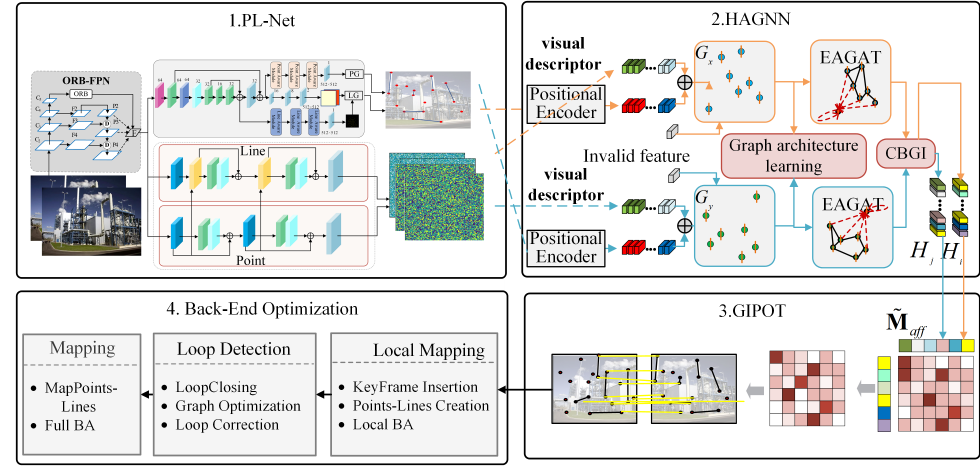
Figure 1. System overview. The system has four components: 1. The point–line feature extraction network (PL-Net) extracts key points, line segment and their descriptors (Section 3.1). 2. A hetero- geneous graph attention network (HAGNN) is added with the positional encoding, which has N EAGAT and GBGI layers (Section 3.2). 3. A greedy near iterative matching (GIPOT) module is used to match the transformed features, which computes the affinity matrix ˜M af f and the assignment